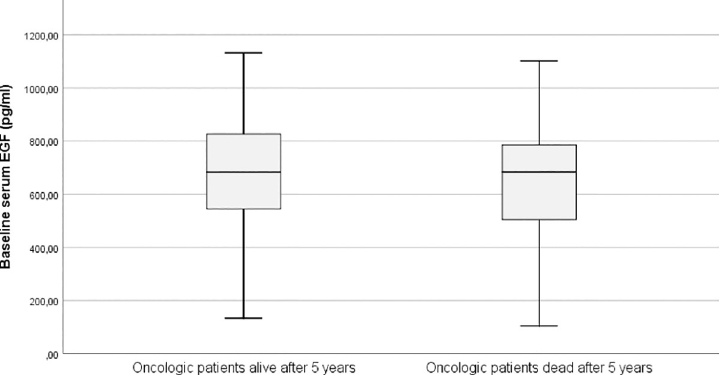
Fig 2. Simple boxplot of baseline serum EGF levels in oncological patients according to 5-year overall survival. The baseline serum EGF levels were similar in the oncological population who was alive after 5 years and the oncologic population who was dead after 5 years (P =